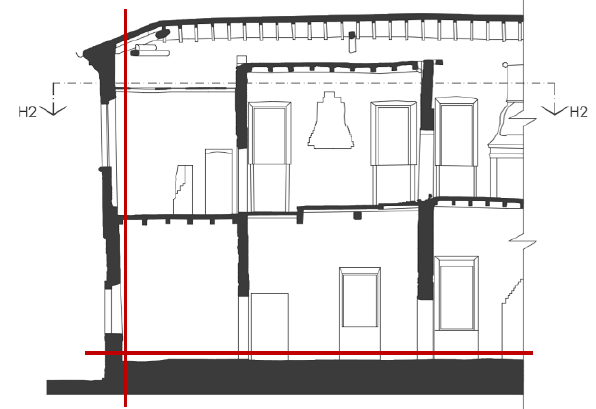
Figure 9: Vertical section V3, the overturning of the external walls and the floor sinking (Municipality of Mantua).